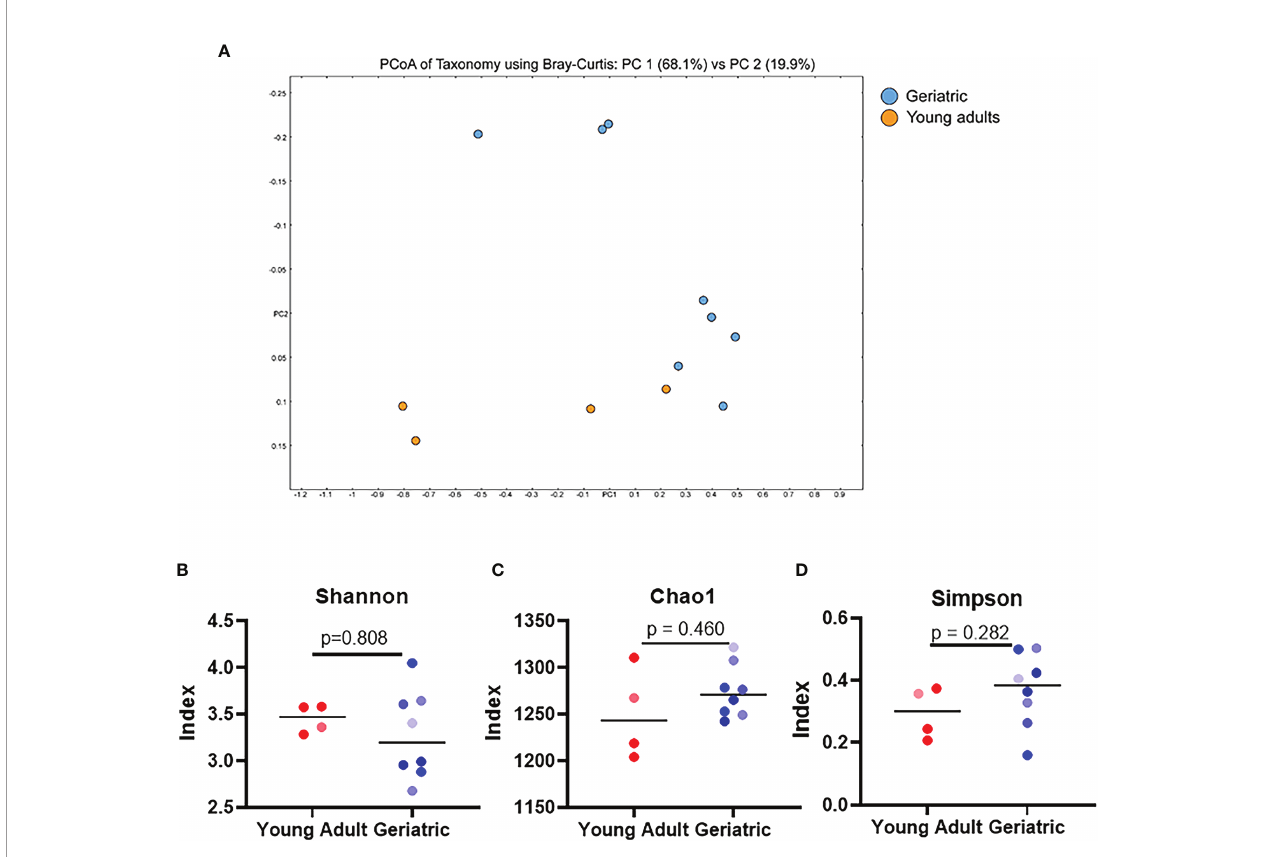
FIGURE 2 | Gut microbial diversity indices of geriatric and young adult animals: (A) , Qualitative differences between the two age groups ( b -diversity), 2D rendering of the Bray-Curtis dissimilarity matrix showing distinct clustering between the two. (B – D) a -diversity indices, namely Shannon (B) Chao1 (C) and Simpson (D) do not exhibit any signi fi cant differences between geriatric (blue dots) and young adult (red dots) animals. Color gradients of the dots indicate the age range with lighter color indicate youngest and darker color indicates the oldest animals of respective group. Test of signi fi cance (B – D) by Mann-Whitney U test, using GraphPad Prism. P- values shown within the graphs are